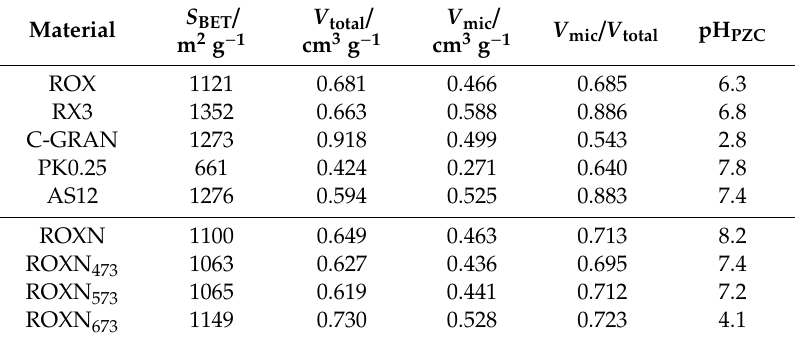
Table 1. Specific surface area ( S BET ), total pore volume ( V Total ), microporous volume ( V mic ) and pH PZC of the AC samples.